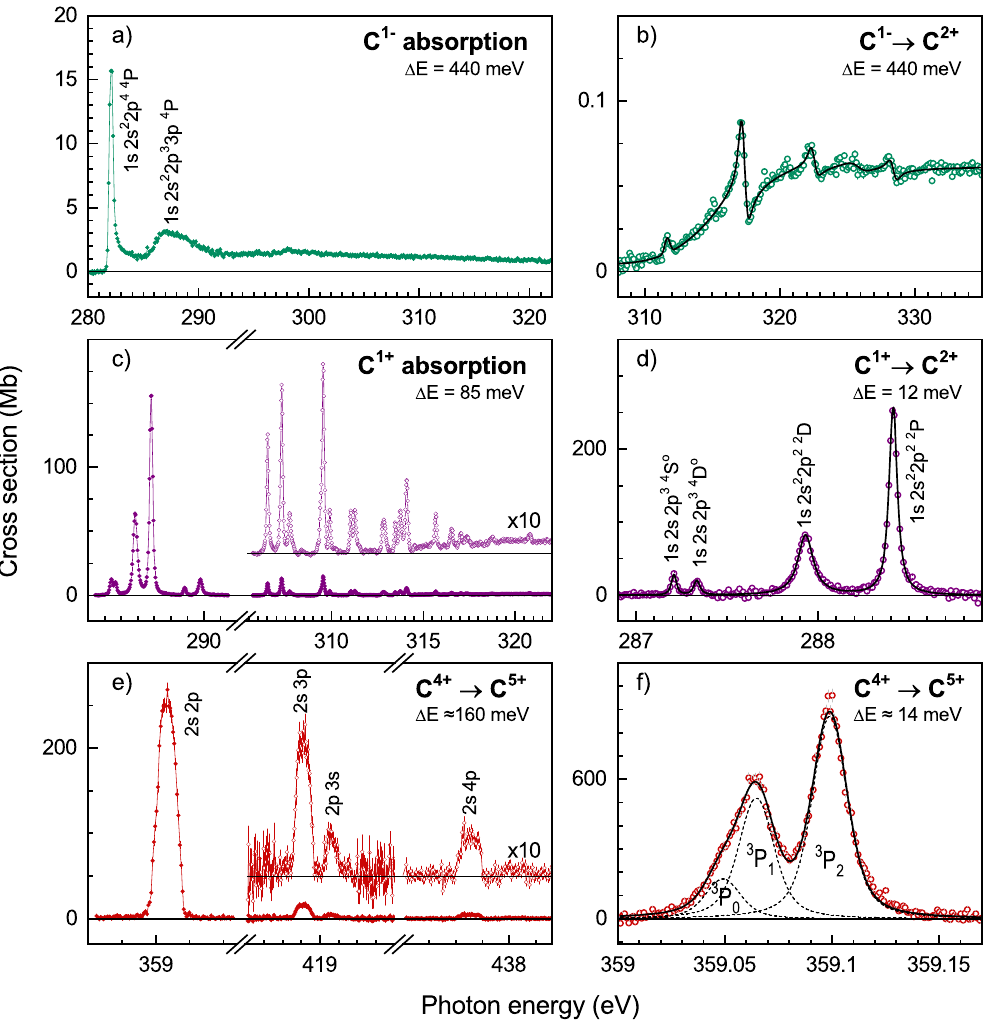
Figure 6. Experimental cross sections for photoabsorption and (multiple) photoionization of C − [67] {panels ( a , b )}, C + [70] {panels ( c , d )}, and C 4 + [34] {panels ( e , f )}. The C + and C 4 + ion beams were mixtures of ground-level and excited metastable ions (see text). For each measurement the experimental photon-energy bandwidth ∆ E is specified. The left panels provide overviews, the right panels feature cross-section details that were measured partly with significantly smaller photon-energy bandwidths. For a better display of the data in panel ( b ), a smooth cross section was subtracted that represented the direct ionization of a 1 s electron (see [67] for details). The full black lines in panels ( b , d , f ) result from resonance fits to the experimental data. The uncertainty of the experimental photon-energy scale is ± 200 meV for C − , ± 30 meV for C + , and (depending on photon energy) ± 40 meV up to ± 50 meV for C 4 +